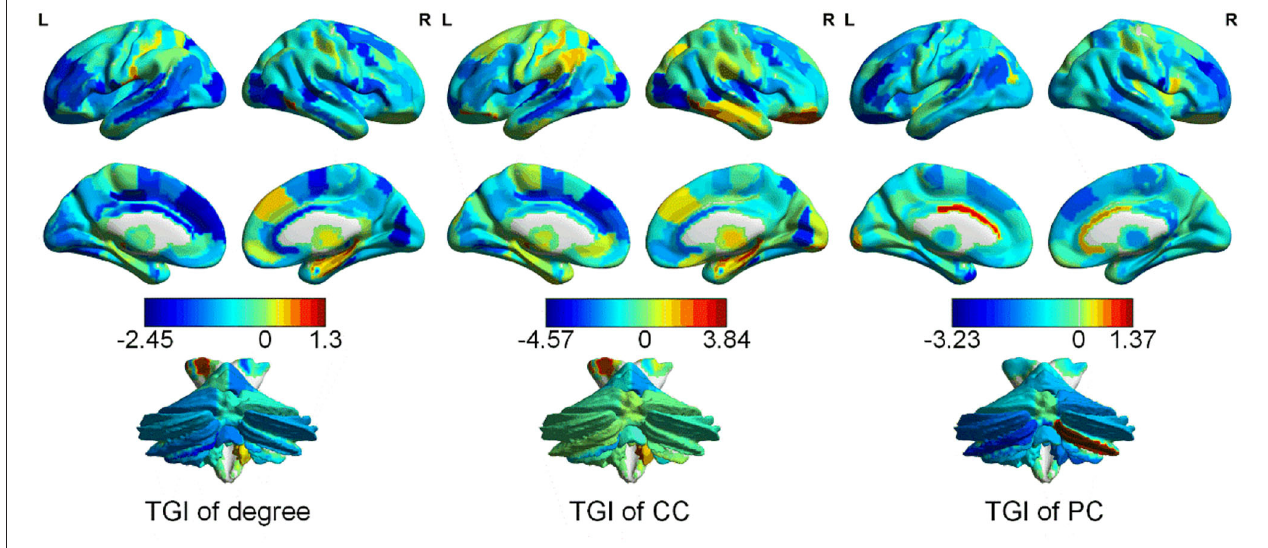
FIGURE 2 | Distribution of the TGI of different network properties [degree, clustering coefficient (CC), and participation coefficient (PC)] in cerebrum and cerebellum.